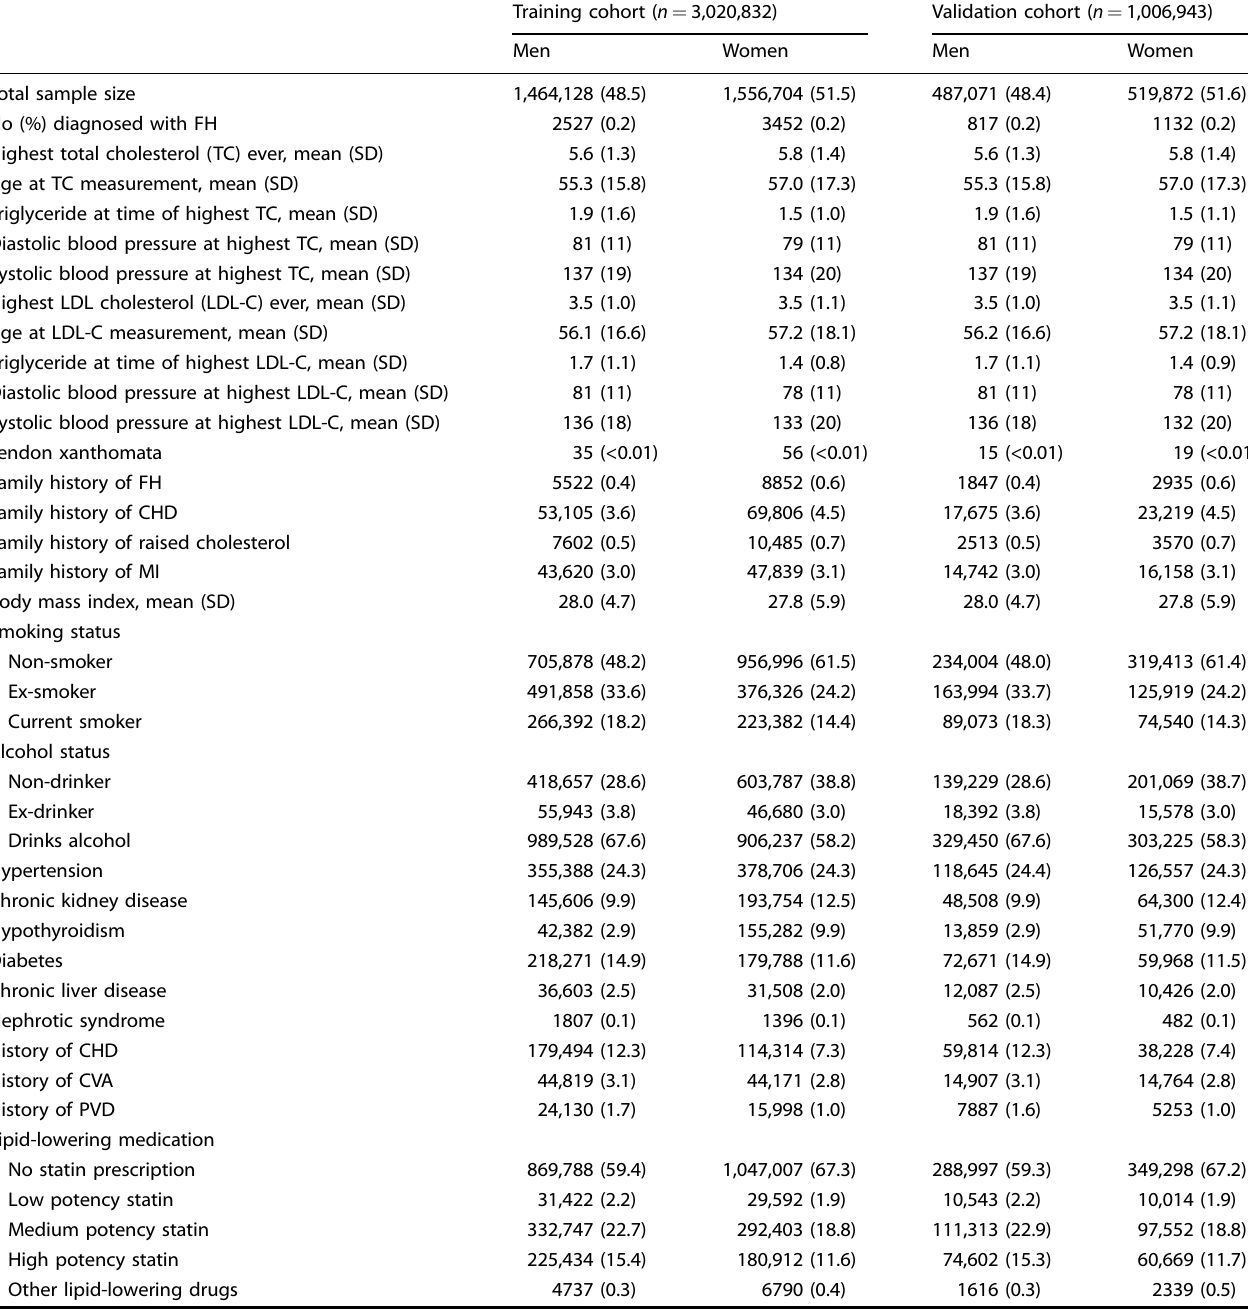
Table 1. Clinical characteristics for men and women age 16 years or above in the derivation and validation